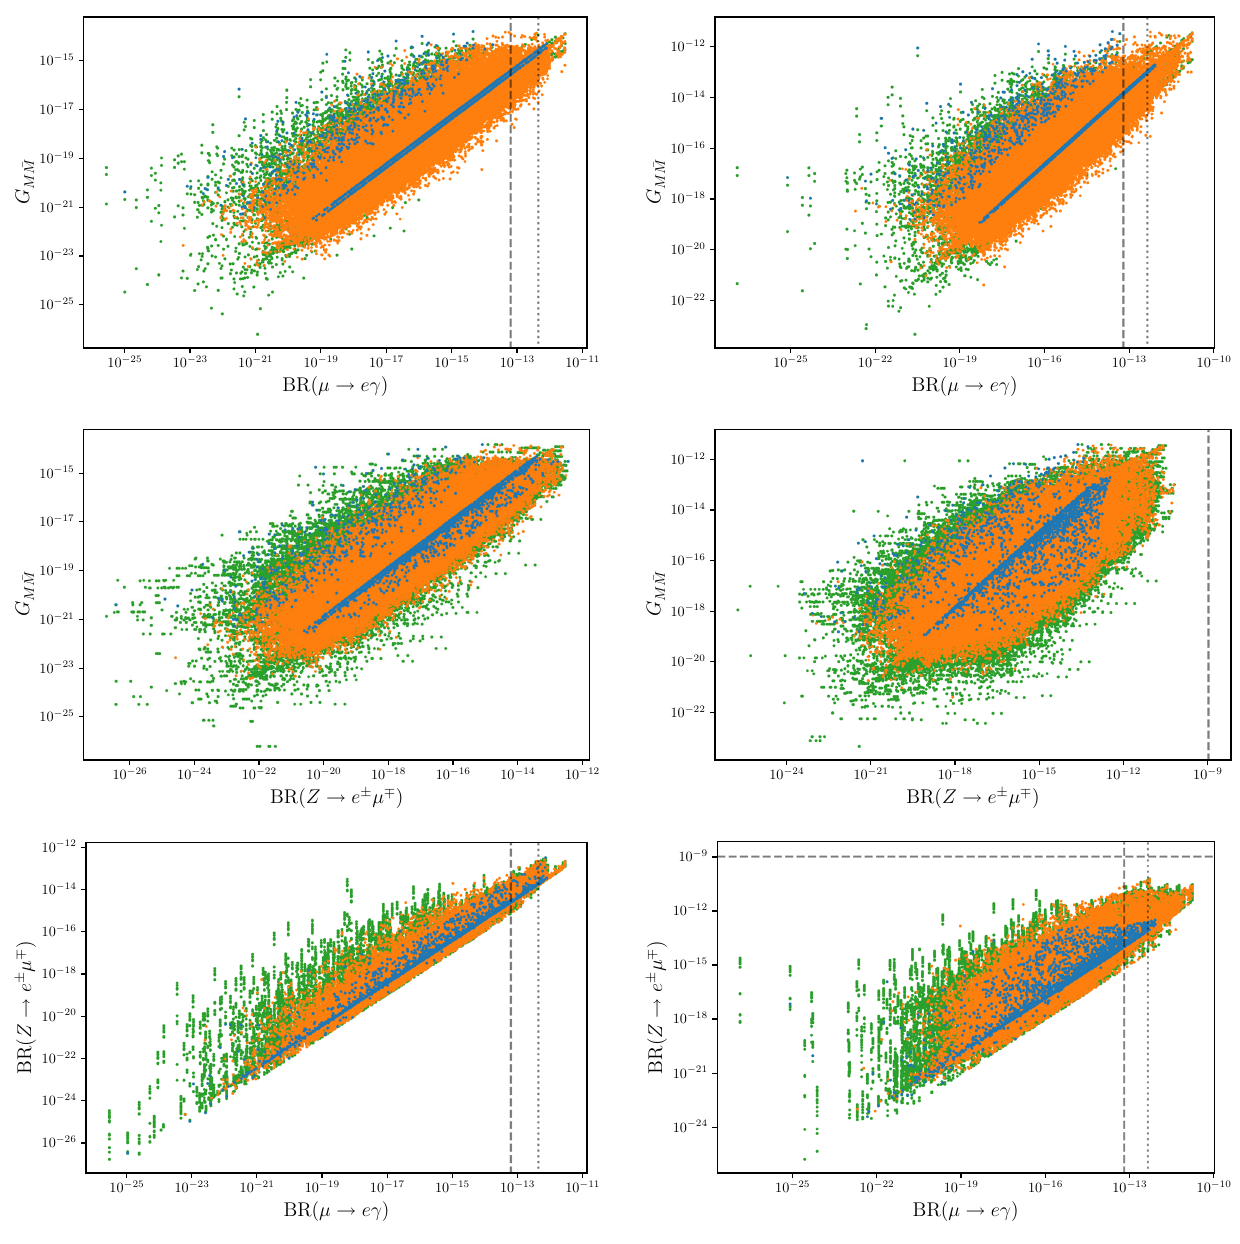
Fig. 12 Correlation of μ − e flavour violating observables (depending on unique topologies), for varying values of the CPV Dirac and Majorana phases: blue points correspond to vanishing phases, orange denote random values of δ α 4 and ϕ 4 in the interval ( 0 , 2 π) , and green points refer to δ α ,ϕ = { 0 , π , π , 3 π ,π } (see text). Dotted (dashed) lines denote current bounds (future sensitivity). On the left panels, m 4 4 4 2 4 on the right we set m 4 = m 5 =